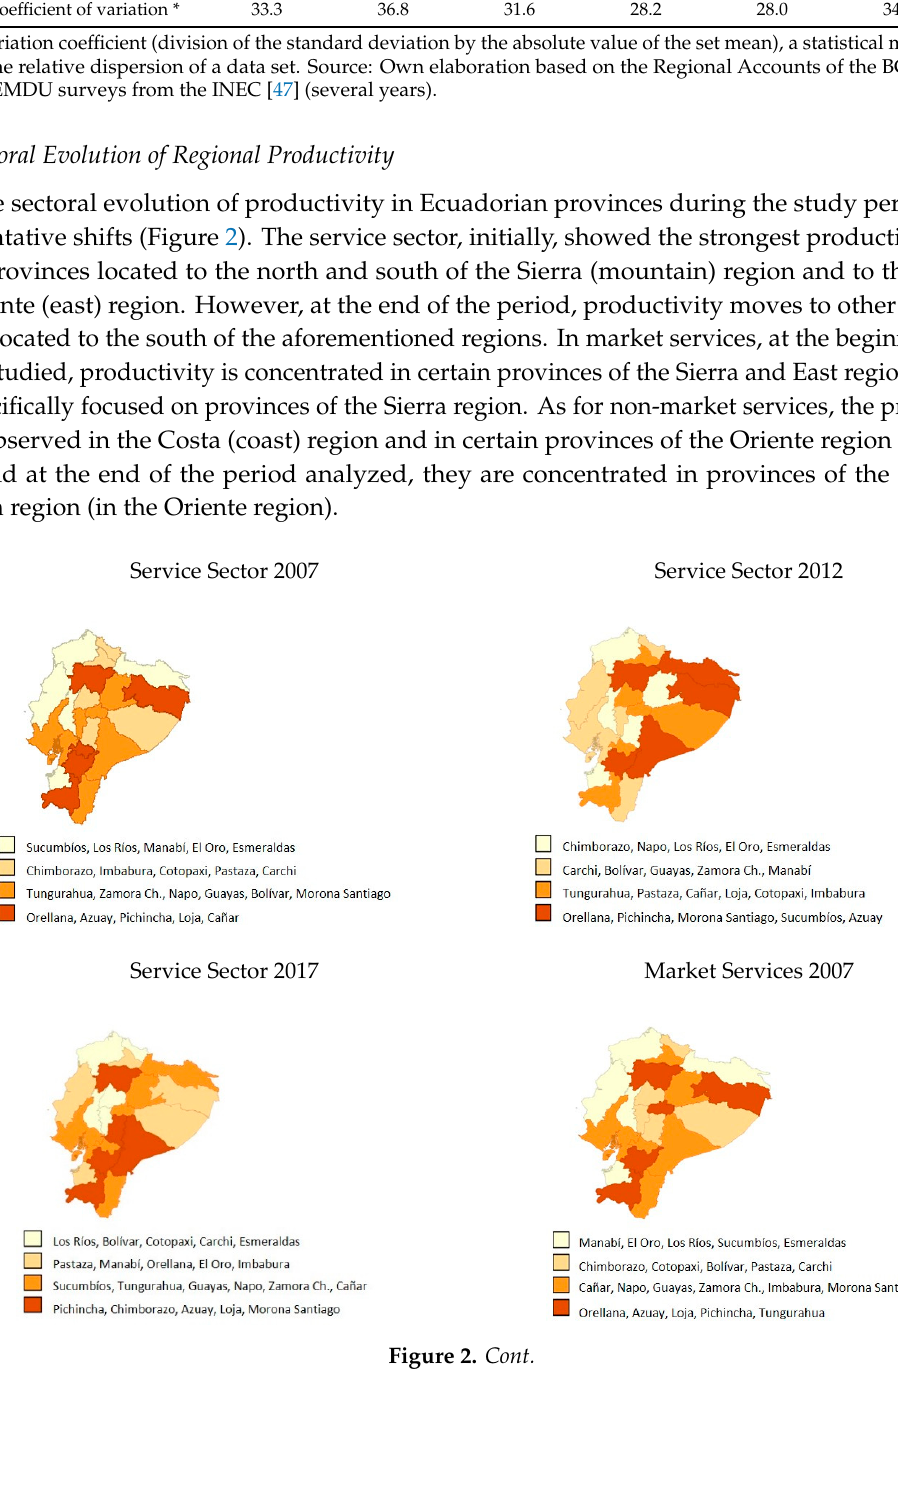
Table 1. Descriptive measures for services and their large groups, 2007–2017.